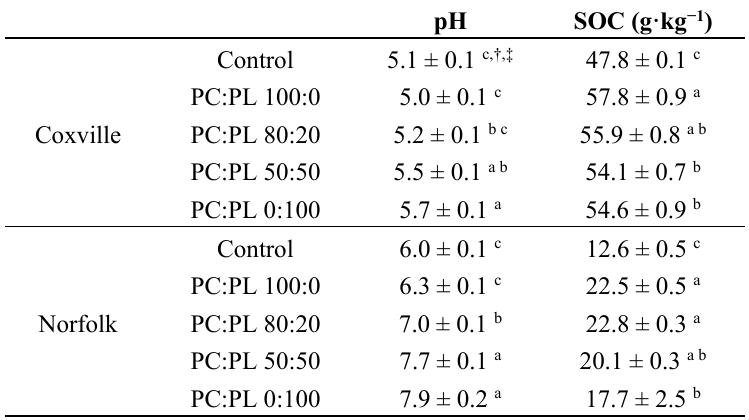
Table 1. pH and soil organic carbon (SOC) after 78 day incubation